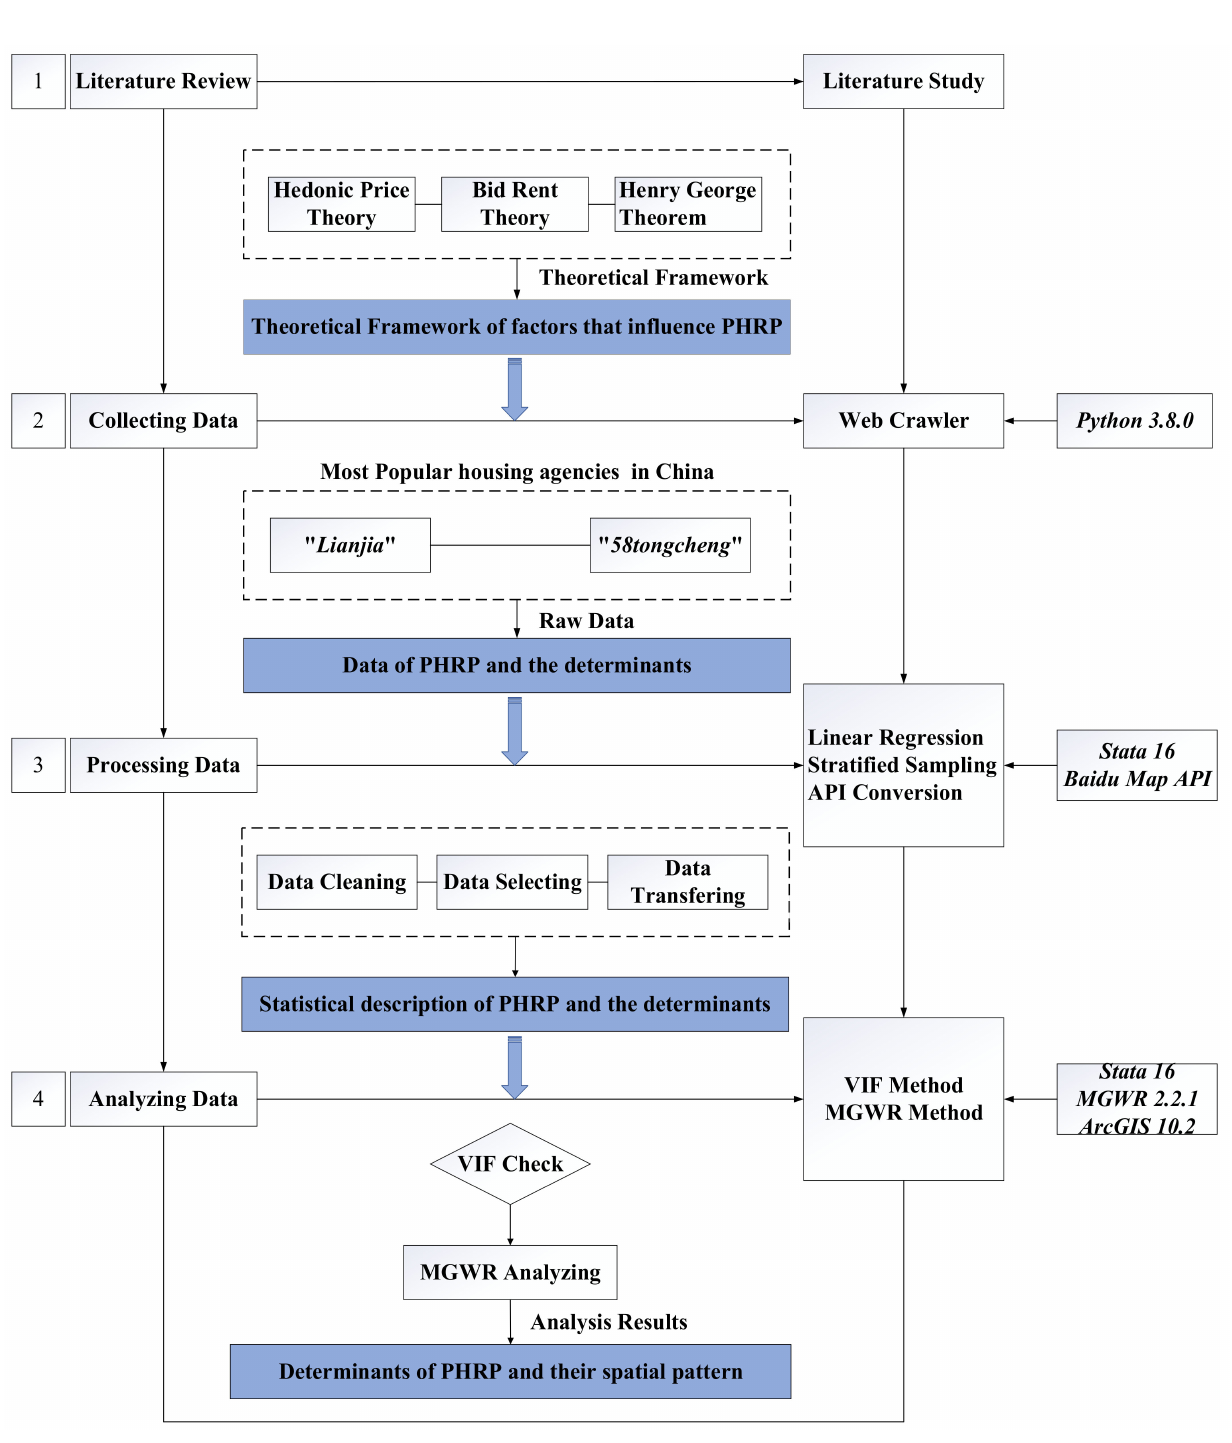
Figure 1. Methodology